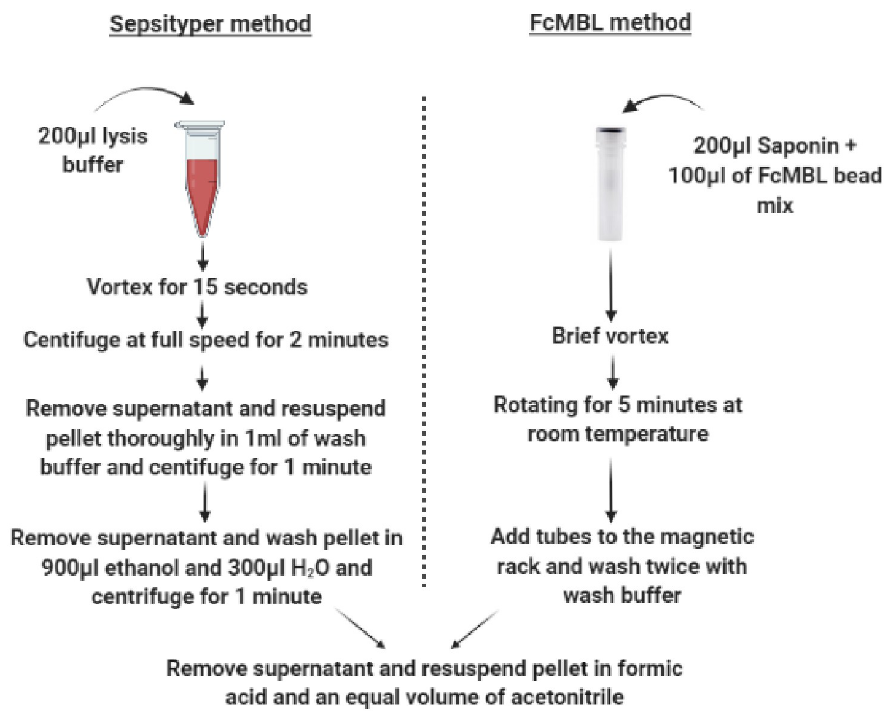
Fig 3. Comparison of the FcMBL and Sepsityper 1 protocols. Time to identification is ~7 minutes for the full Sepsityper 1 workflow compared to ~9 minutes for the FcMBL